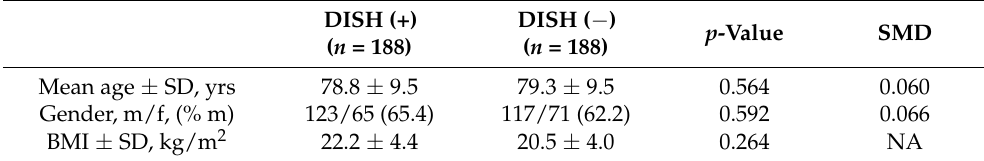
Table 2. Patients’ demographic data post sample matching using propensity score.